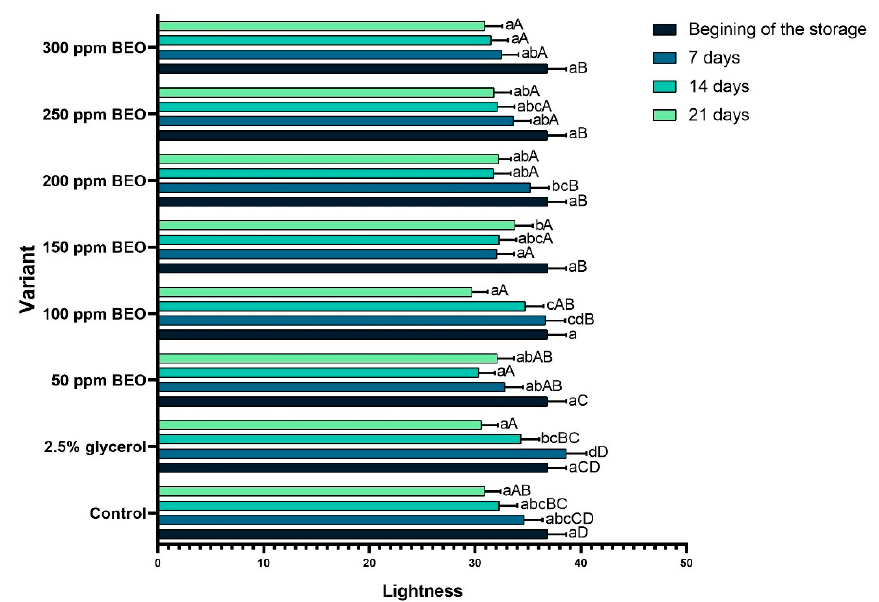
Figure 7. Effects of applied treatments on the Lightness (fruit color parameter) during storage for 21 days at 8 ± 1 ◦ C. Bars for the same sampling time followed by different lowercase letters are significantly different based on the least significant difference (LSD) test ( p < 0.05). Bars for the same treatment during storage time followed by different uppercase letters are significantly different based on the least significant difference (LSD) test ( p < 0.05).